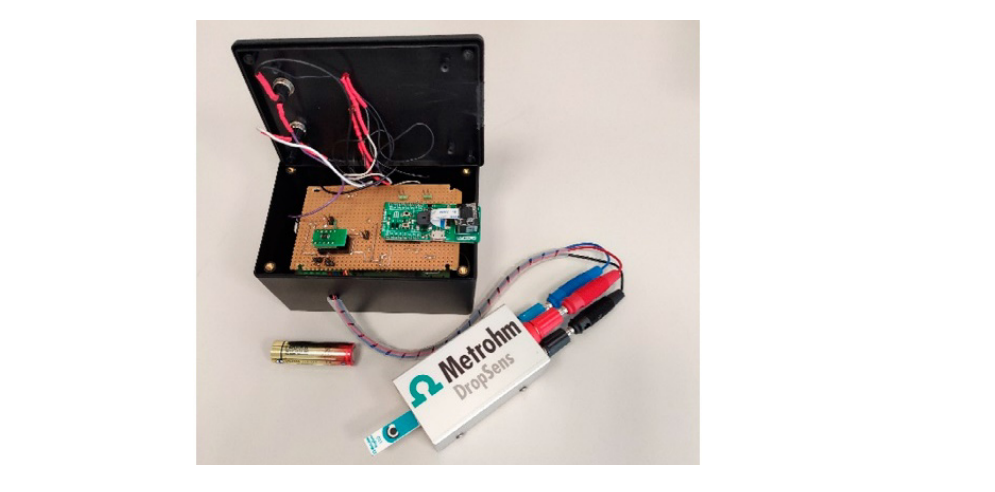
Figure 2. The smart portable wireless potentiostat for Rapid Quantification of SARS-CoV-2 Spike Protein. Reprinted with permission from ref. [80].